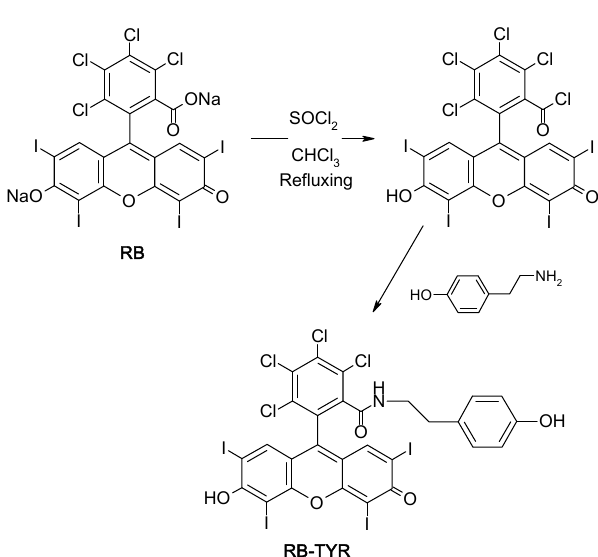
Figure 12. The scheme of the RB–TYR synthesis. Int. J. Mol. Sci. 2020 , 21 , x FOR PEER REVIEW